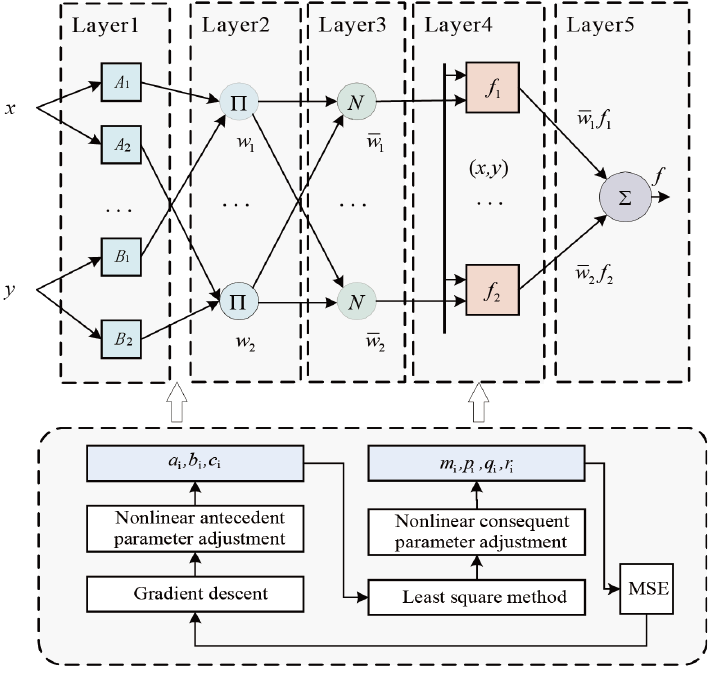
Figure 7. Schematic diagram of ANFIS.